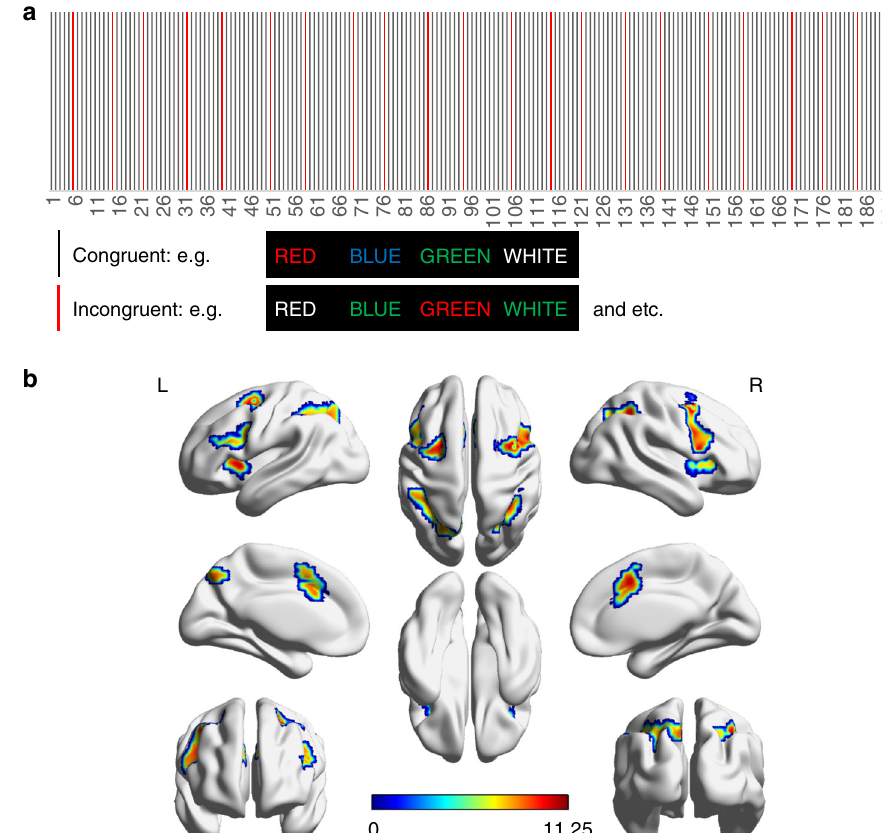
Fig. 1 Experimental paradigms of the Stroop word-color task and the group activation map. a Experimental paradigms of the Stroop word-color task. Twenty-two incongruent words were shown randomly across each session with the interval between any two incongruent words no shorter than 14 s ( = 7 TRs). b Seven activated clusters (two sample t -test, FWE corrected) were symmetrically distributed in bilateral hemispheres, including the anterior cingulate gyrus, dorsomedial frontal cortex (dmPFC), bilateral middle frontal gyrus, bilateral inferior frontal gyrus, bilateral superior parietal gyrus, bilateral inferior parietal gyrus, bilateral precuneus, bilateral insular cortex and right angular